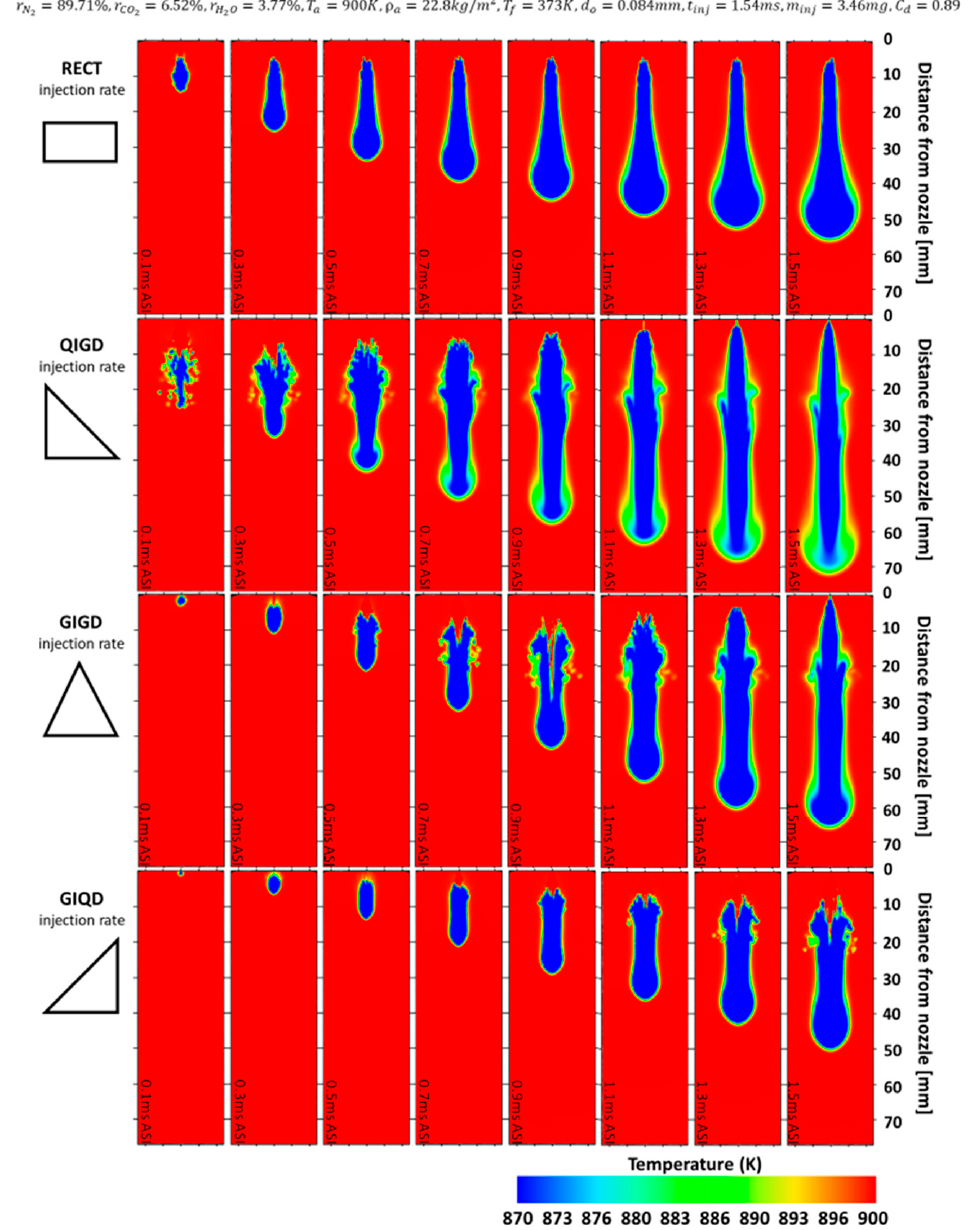
Figure 18. Comparison of the temperature distribution during injection for different injection rate Figure18. Comparisonofthetemperaturedistributionduringinjectionfordi ff shapes.